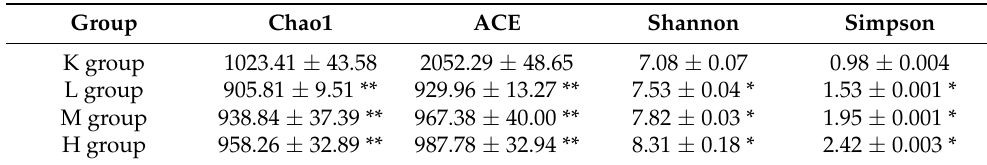
Table 2. Effects of anthocyanins on the alpha diversity index of gut microbiota.